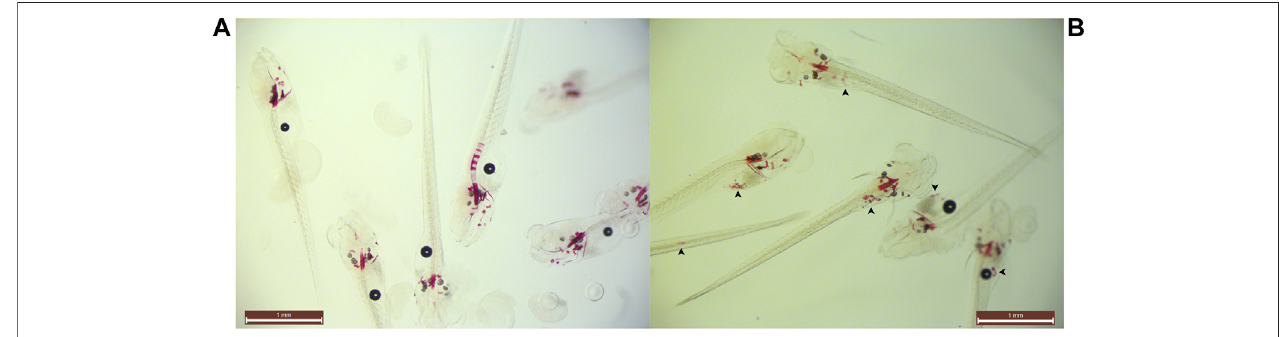
FIGURE 3 | Example of ectopic speckling following 35 µM STS-treatment. Snapshot group images of (A) control and (B) 35 µM STS-treated larvae at 10 dpf with unknown genotypes. 35µM sodium thiosulfate abolished spinal mineralization and concomitantly ventral mineralized nodules were identi fi ed (arrowheads) in all treated animals. Opacity of the specimens prevented identi fi cation of the anatomical sites of the nodules.